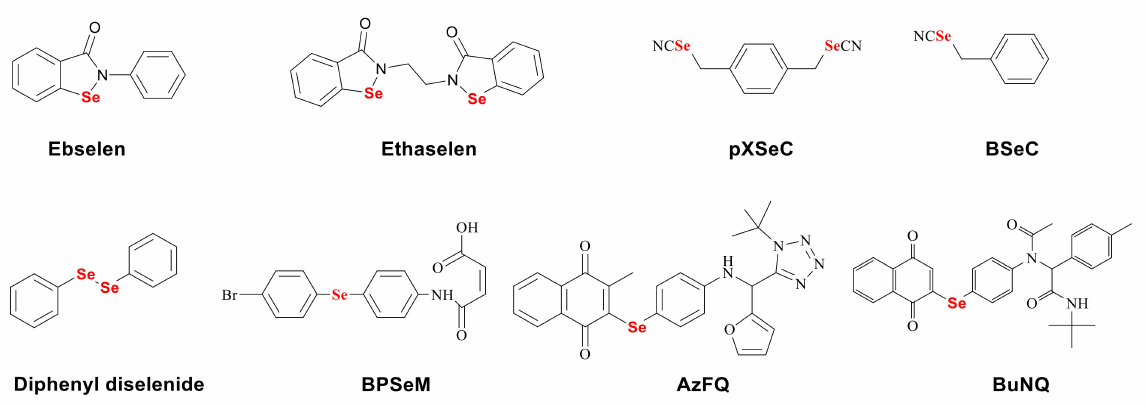
Figure 1. Structure of pharmacologically active OSe